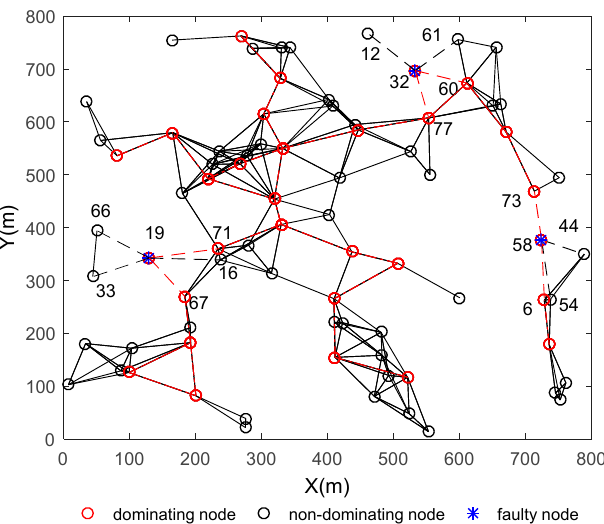
Figure 6. The initial network situation in which the total node number is set as 80 and communication range is set as 120 m.